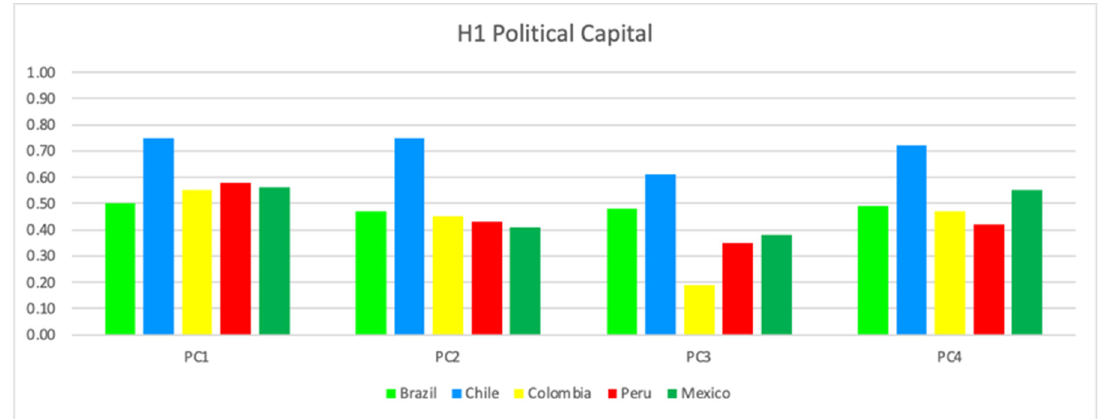
Figure 2. Political Capital (PC). Source: Own elaboration based on [45].